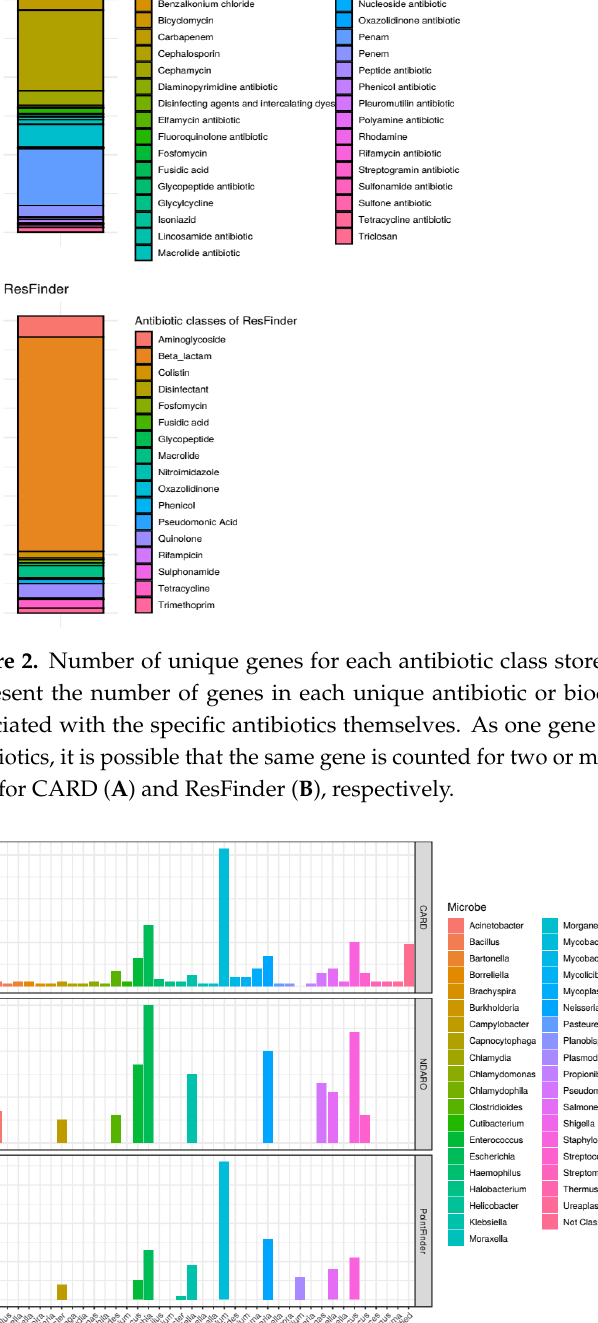
nal publication has also been updated.